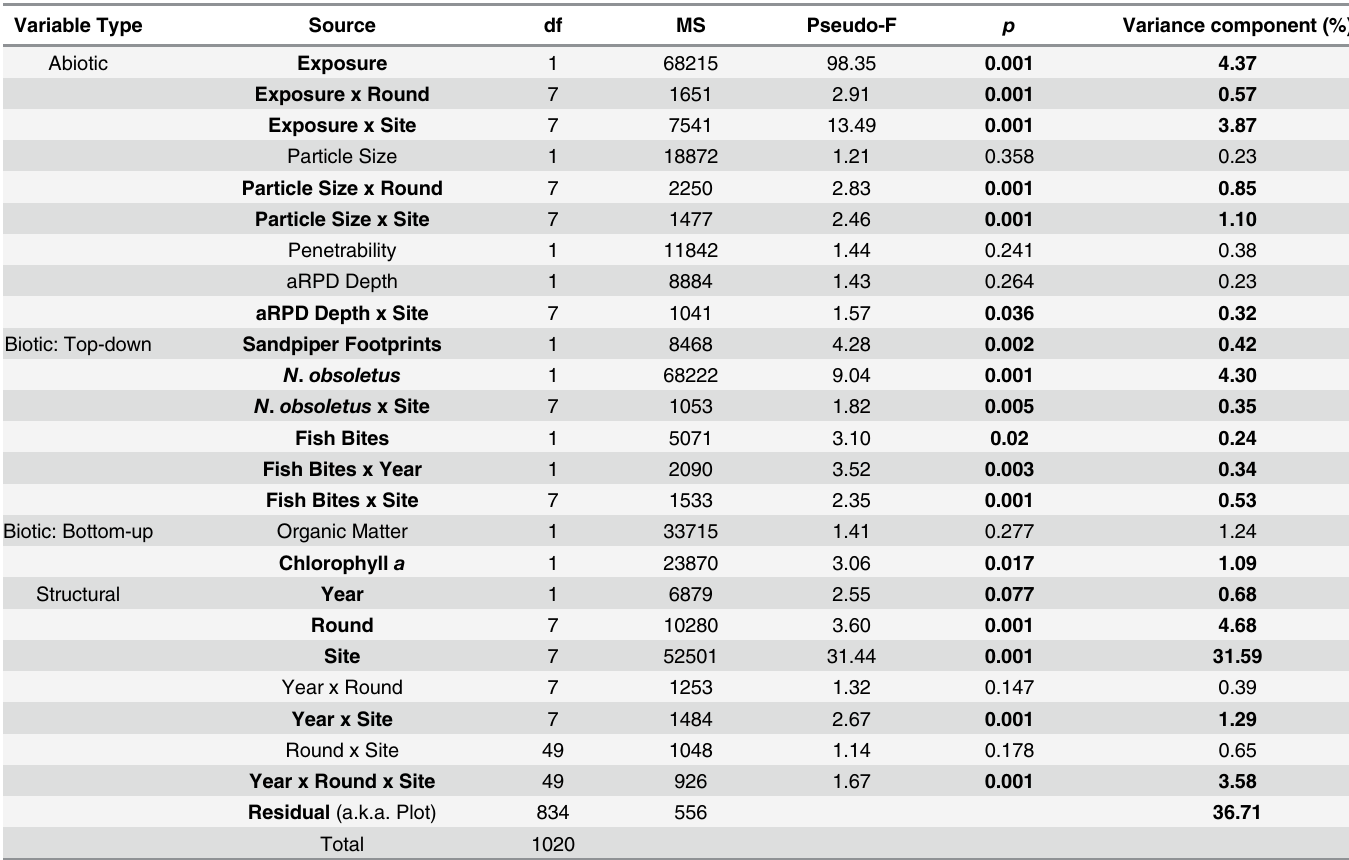
Table 1. Results of PERMANCOVA determining which of the covariates and structural factors were associated with the infaunal community change over space and time for Bay of Fundy mudflats in 2009 – 2011. We used 996 – 999 unique permutations. Significant p values are in bold. Only interactions between structural factors and covariates that were significant are